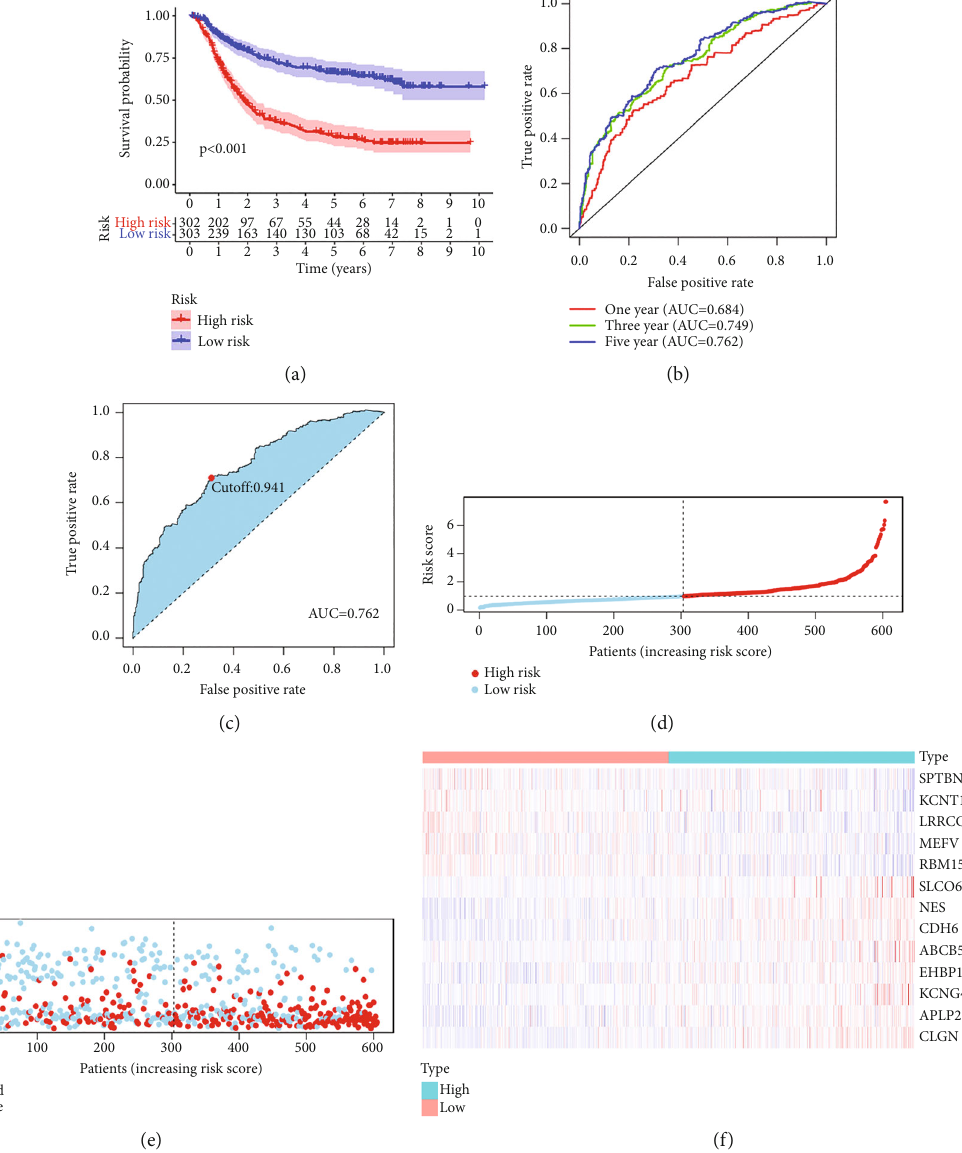
Figure 2: (a) Predictive function of the risk signature in training set. Kaplan-Meier analysis was conducted to determine survival di ff erence between the high-risk group and the low-risk group. (b, c) Receiver operating characteristic (ROC) curve was plotted to assess the accuracy of the signature in predicting patients ’ survival outcomes. (d, e) Patients were ranked according to risk score value, and the survival status of the patients was visualized. (f) A heatmap was plotted to visualize the expression pattern di ff erence of the genes in the signature between the high-risk group and the low-risk